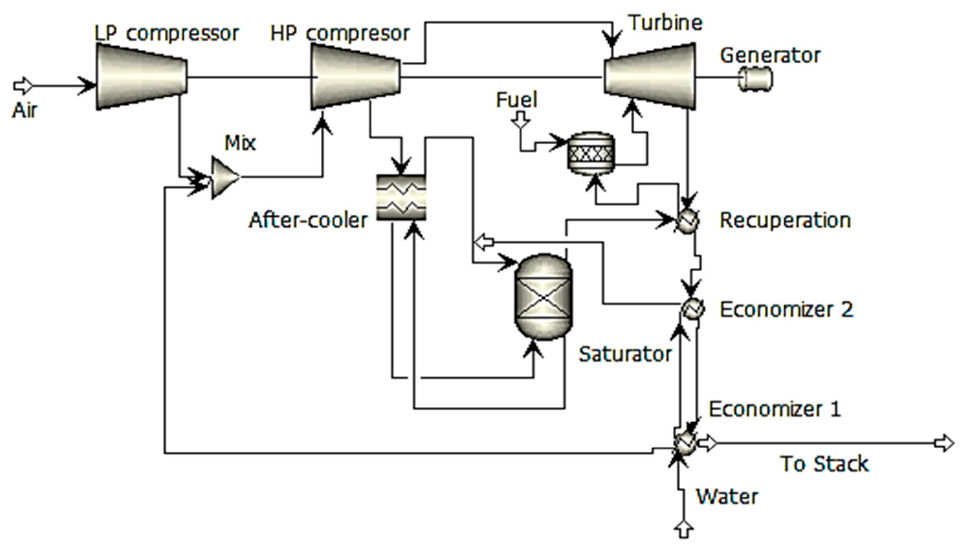
Figure 7. Conceptual plant diagram for the 3HAWIT cycles of inter-cooled, humid air injection.